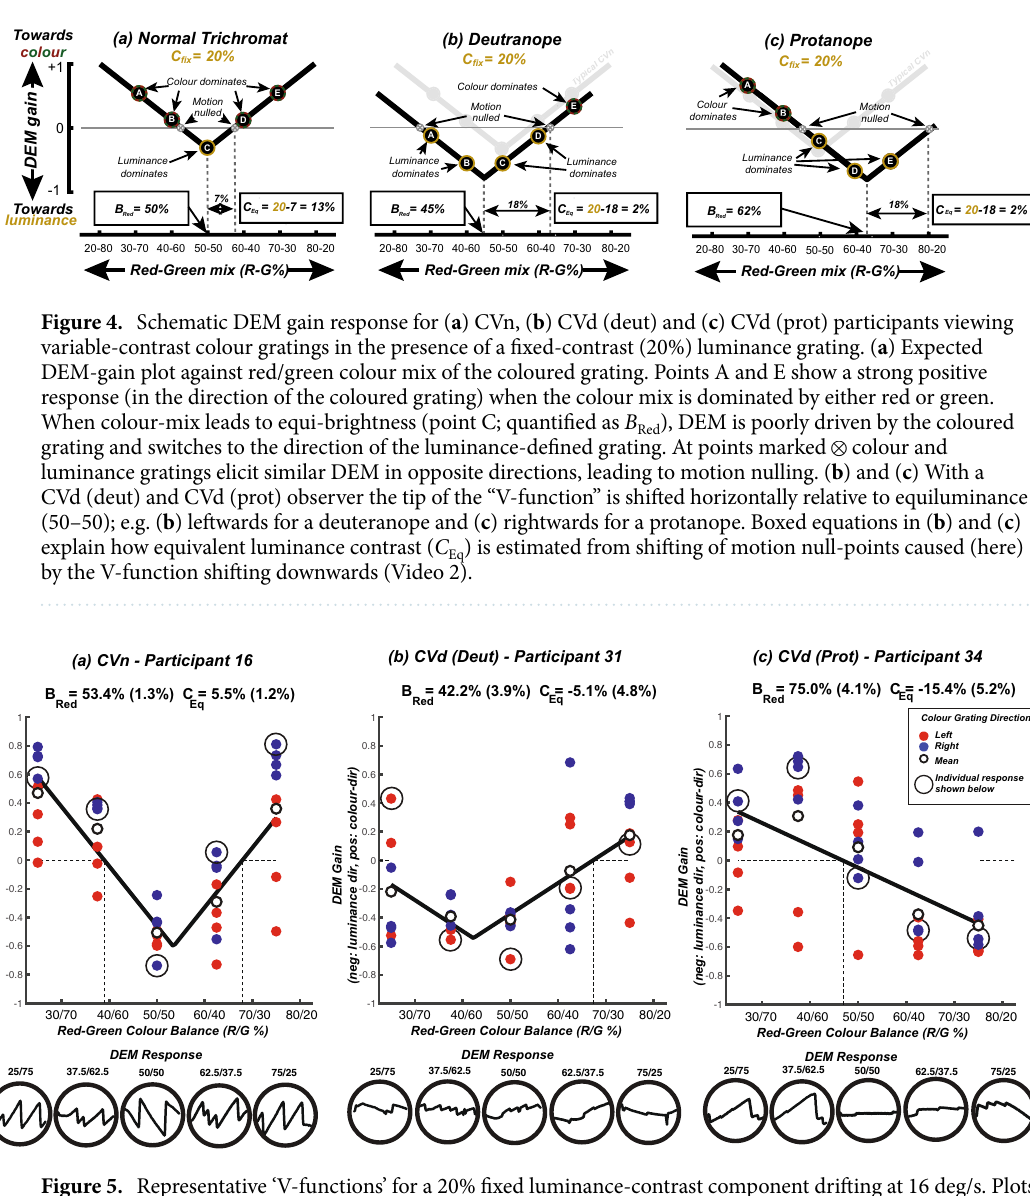
Figure 5. Representative ‘V-functions’ for a 20% fixed luminance-contrast component drifting at 16 deg/s. Plots show data from ( a ) a participant with normal colour vision, ( b ) a deuteranope and ( c ) a protanope. In total 8 trials for each red-green condition were carried out: in 4 trials the coloured grating moved left (red symbols), and in 4 it moved right (blue symbols). The V function was fit to the average DEM-gain across trials (small open symbol). Note the left/right shifting of the V functions in ( b ) and ( c ), indicating a shift in the red-green equiluminant point. Note also that in ( b , c ) the end-points of the V-functions are shifted downwards indicating a weak contribution of colour to these participants’ perception of motion 13 . The raw eye-position plots at the bottom of the figure are for conditions corresponding to the circled datapoints in the